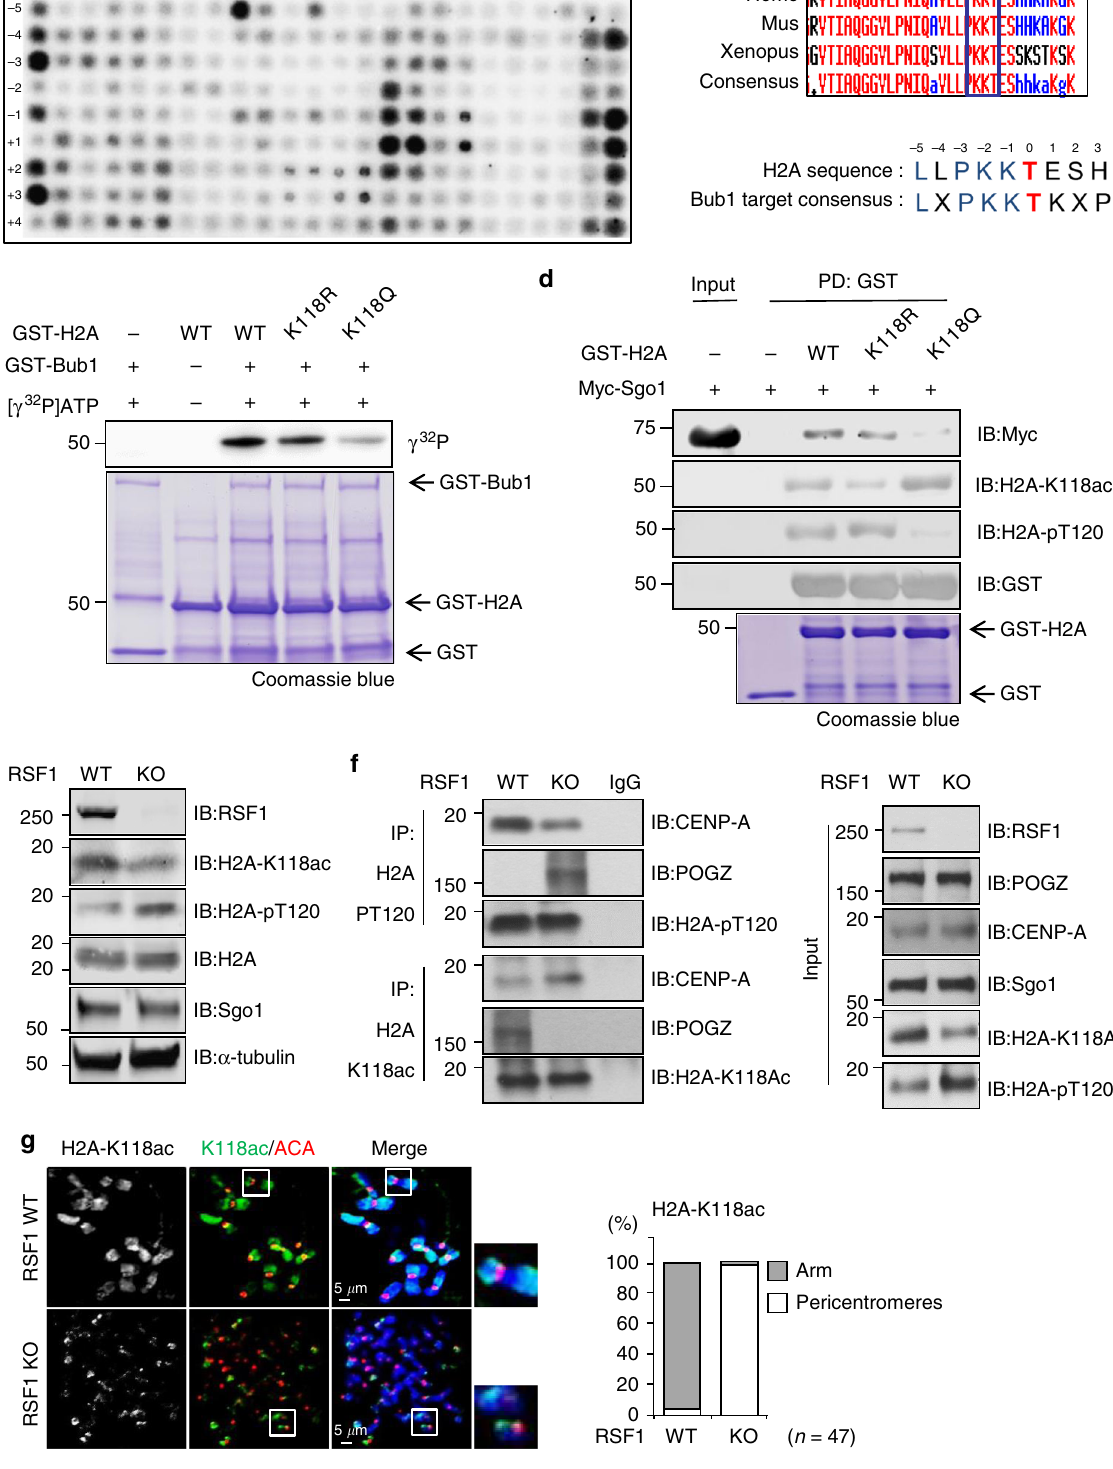
Fig. 2c, phosphorylation on H2A-K118Q by Bub1 kinase was signi fi cantly reduced, whereas phosphorylation of the H2A- K118R variant was similar to that of wild type H2A, suggesting that acetylation of the Lys118 inhibits the phosphorylation of H2A by Bub1. Next, the immobilized histone variants were incubated with mitotic cell lysates expressing Myc-Sgo1 and